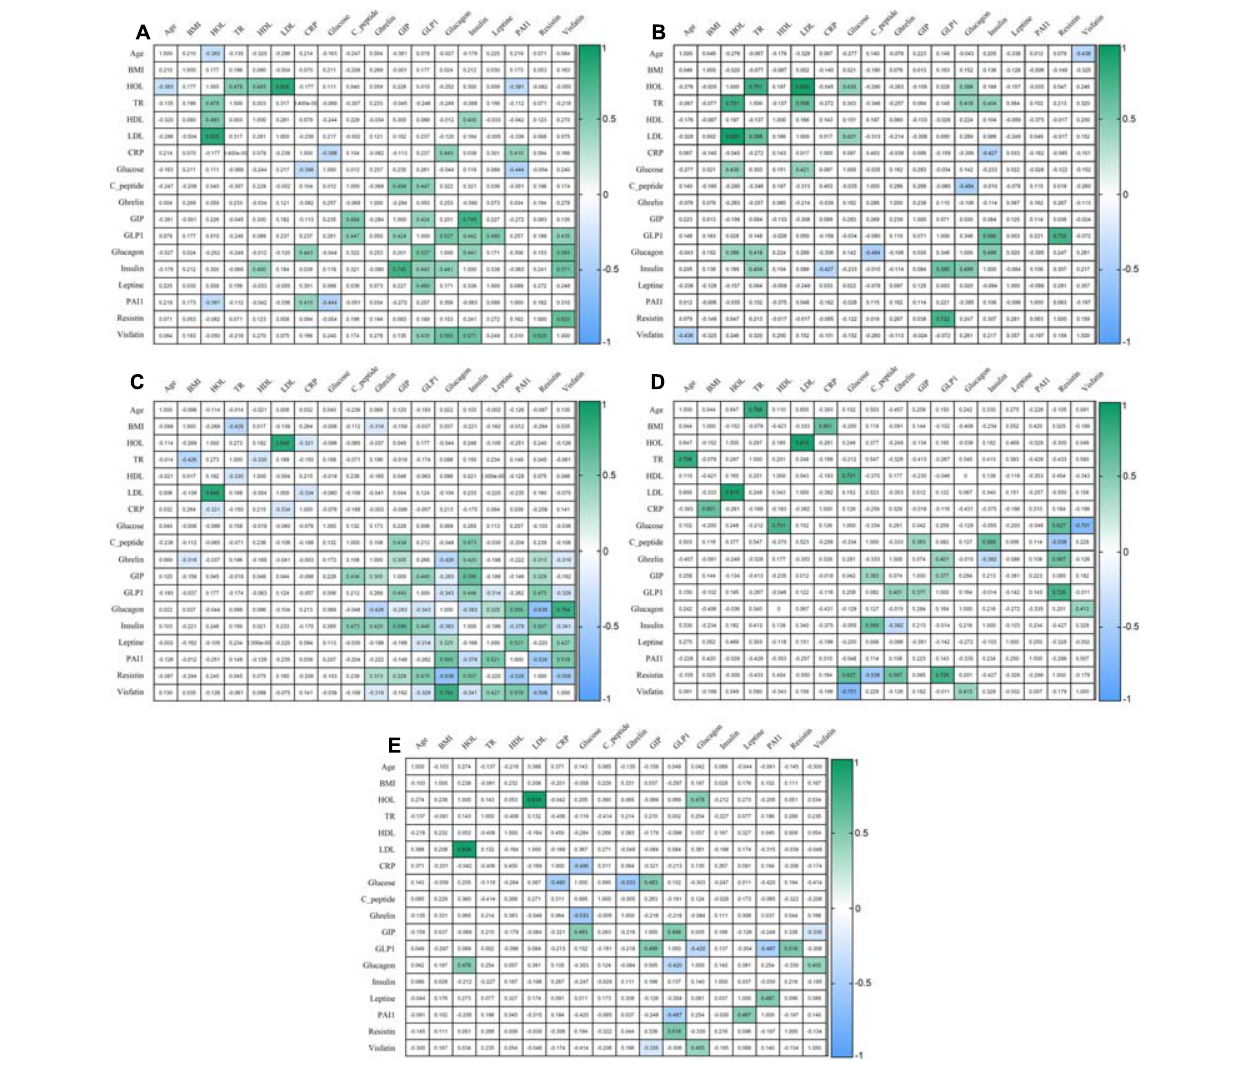
FIGURE 3 | Correlation of mediators. (A) Correlation in the healthy volunteers; (B) Correlation in an obese patient without T2DM; (C) Correlation in an obese patient with T2DM; (D) Correlation in patients 6 months after LSG; (E) Correlation in patients 6 months after RYGB. The analysis was performed using Pearson’s test